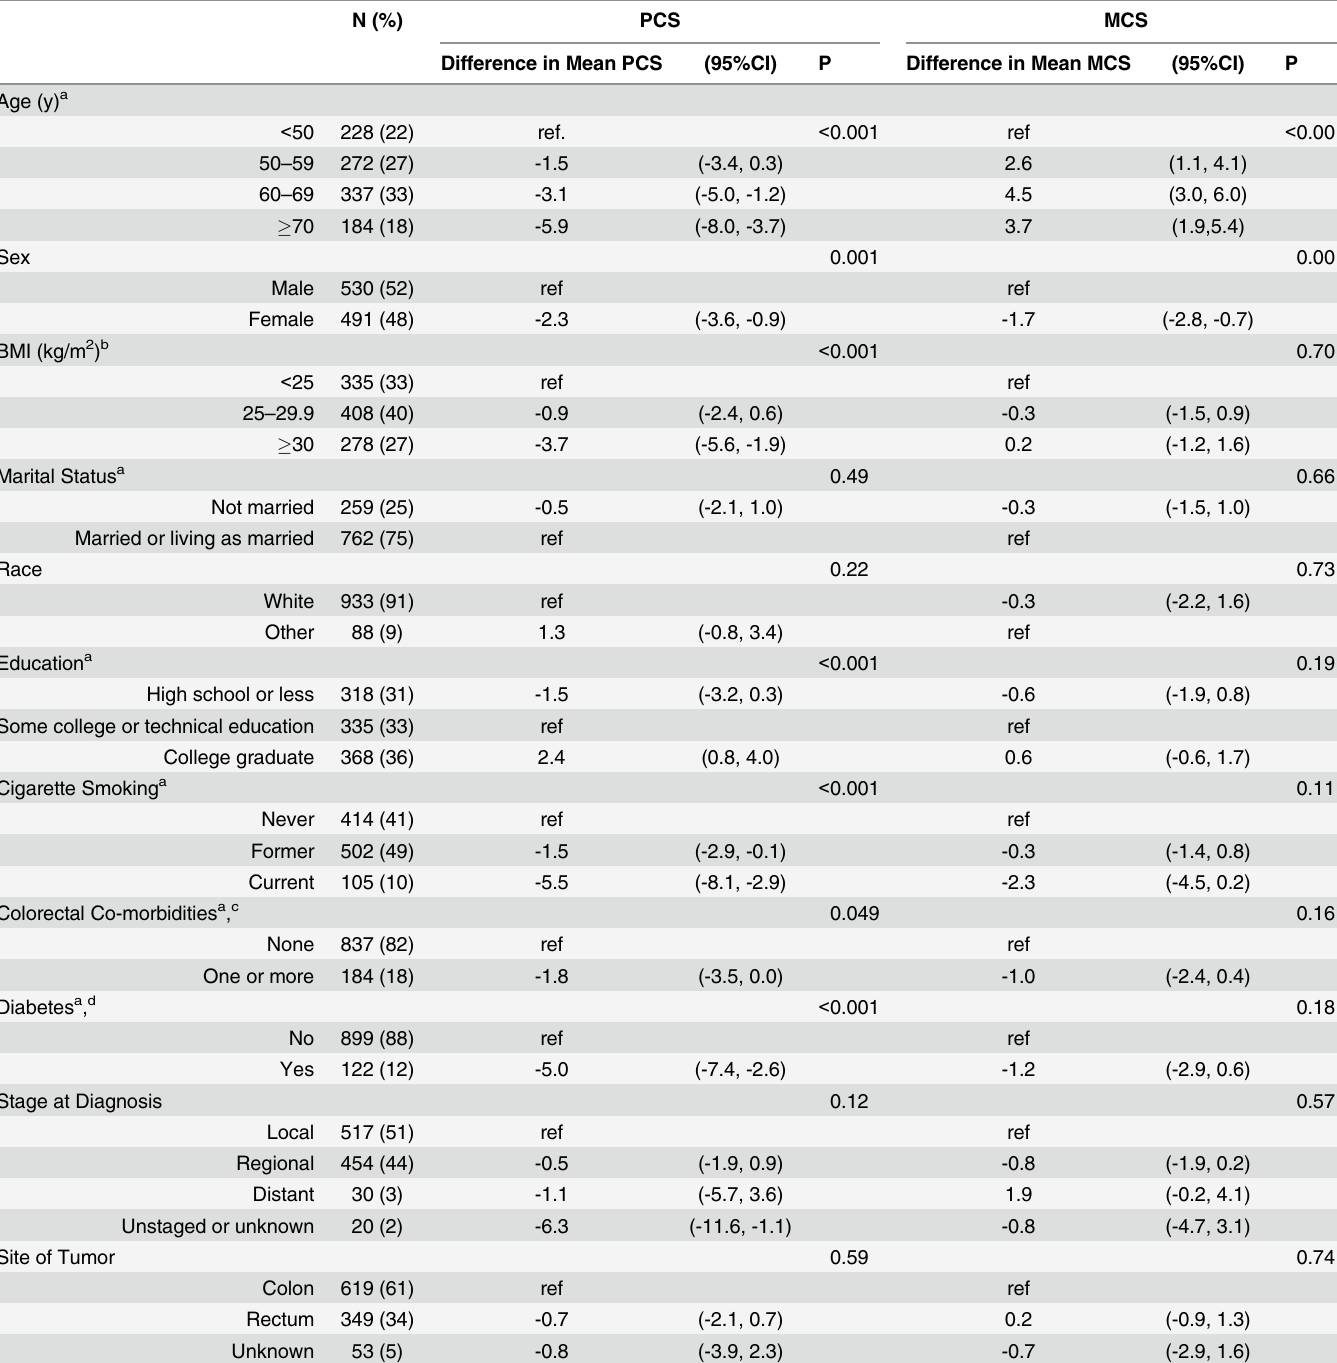
Table 1. Association of personal characteristics at enrollment with mean Physical Component Summary (PCS) and Mental Component Summary (MCS) scores from the VR-12, for survivors at 5 year follow-up in the Seattle Colorectal Cancer Family